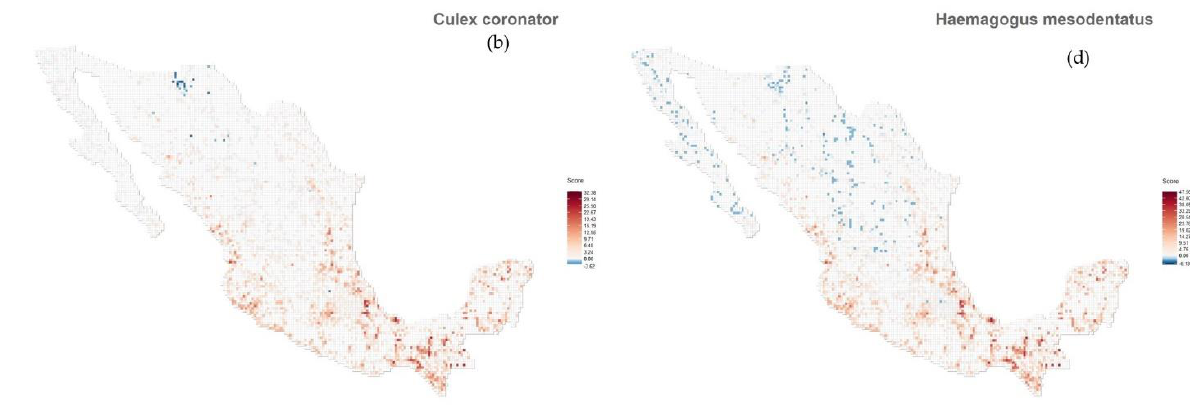
Figure 5. Predicted map distribution. ( a ): Aedes aegypti, ( b ): Culex coronator, ( c ): Culex quinquefasciatus and ( d ): Hae-